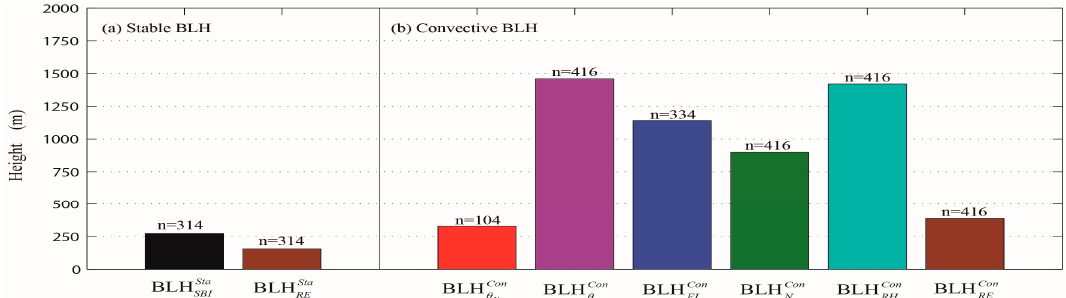
Figure 3. Average BLHs of stable boundary layer ( a ) and convective boundary layer ( b ) in Beijing